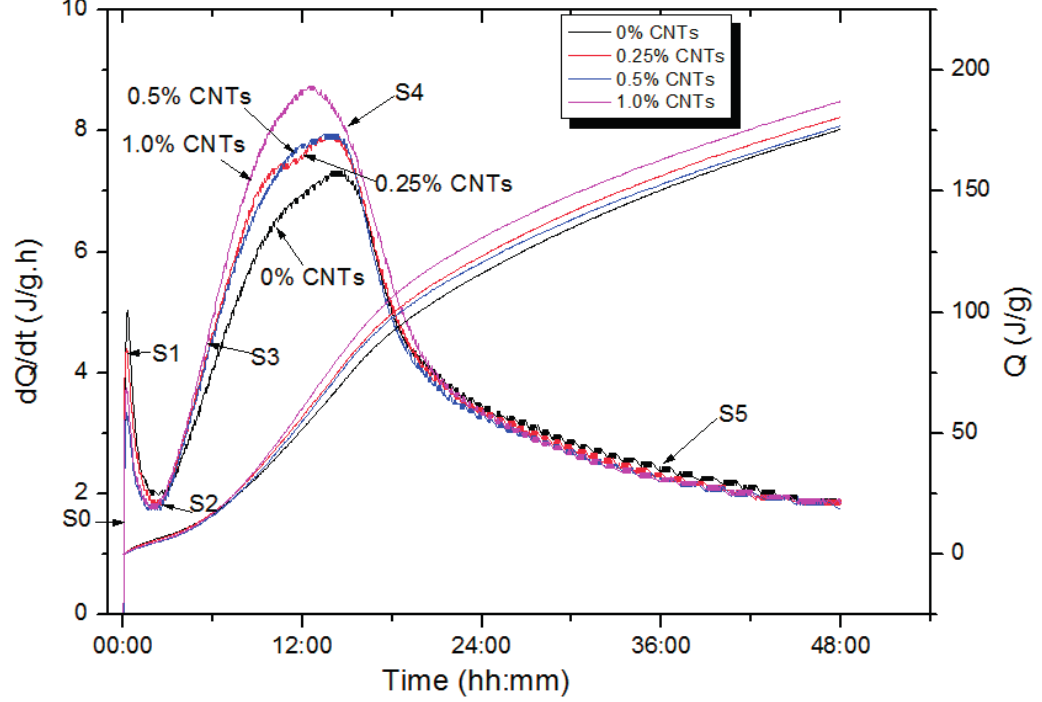
Figure 1. Heat flow calorimetry of 10%-microencapsulated phase change materials cement paste (MPCM-CP) with different dosages of carbon nanotubes